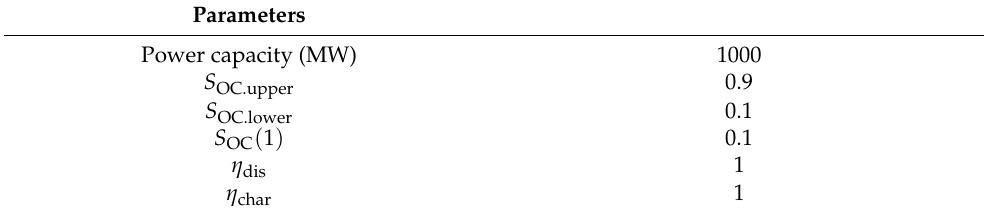
Table 3. Parameters of ESS.